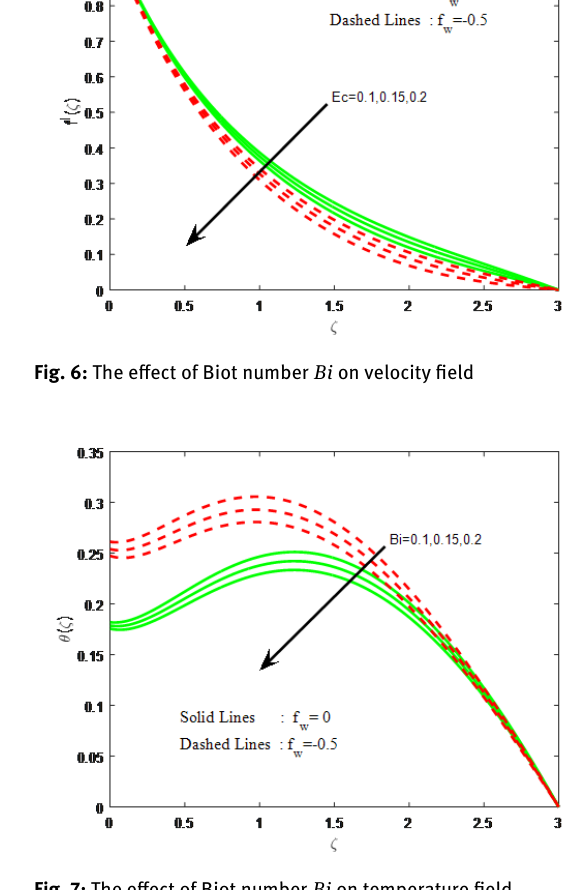
Fig. 4: The effect of heat source parameter Q H on velocity field